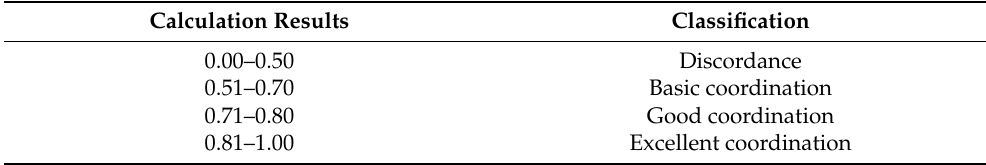
Table 3. The classification of coupling coordination